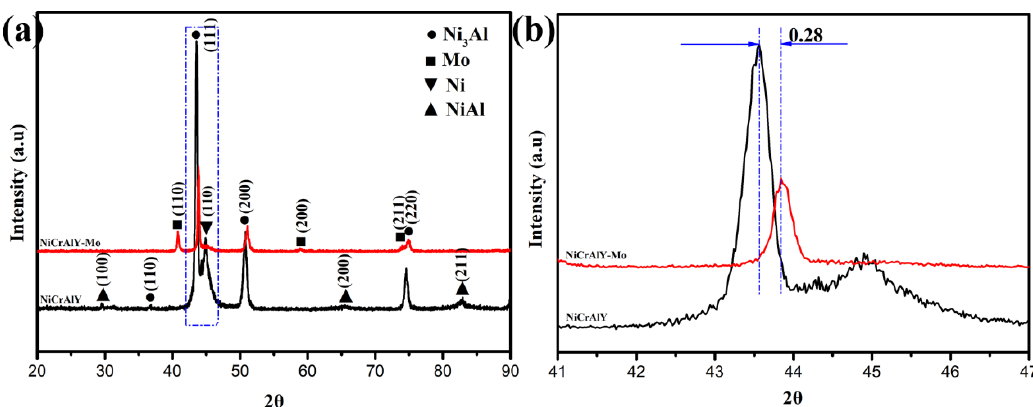
Figure 3. ( a ) XRD patterns of NiCrAlY and NiCrAlY-Mo coatings and ( b ) magnification of the region in ( a ).